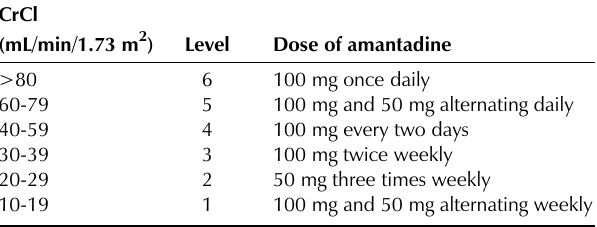
TABLE 1 Amantadine hydrochloride dose recommended by the Canadian National Advisory Committee on Immunization guidelines by renal status for persons aged 65 years and